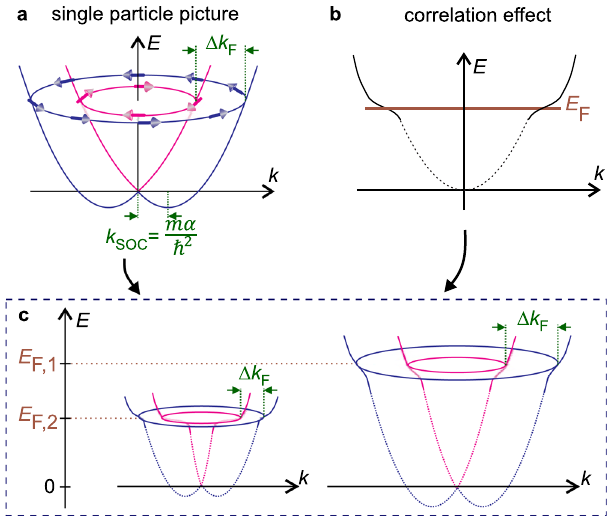
Fig. 3 Evolution of spin – orbit split band structure due to Coulomb interaction. a Upon exposing a free electron system to the SOC H SOC = α ( σ x k y − σ y k x ), the energy dispersion becomes E + / − ( k ) = ℏ 2 k 2 /2 m ± α k . Here the electron mass m and SOC coef fi cient α are k -independent, and the relation holds Δ k F = 2 k SOC . b The effect of Coulomb interaction can be thought as fl attening of energy dispersion at the Fermi energy. c Schematic representation of effect of Coulomb interaction on spin – orbit split band structure at two Fermi energy values E F,1 and E F,2 . The electron correlation effects are stronger pronounced at smaller Fermi